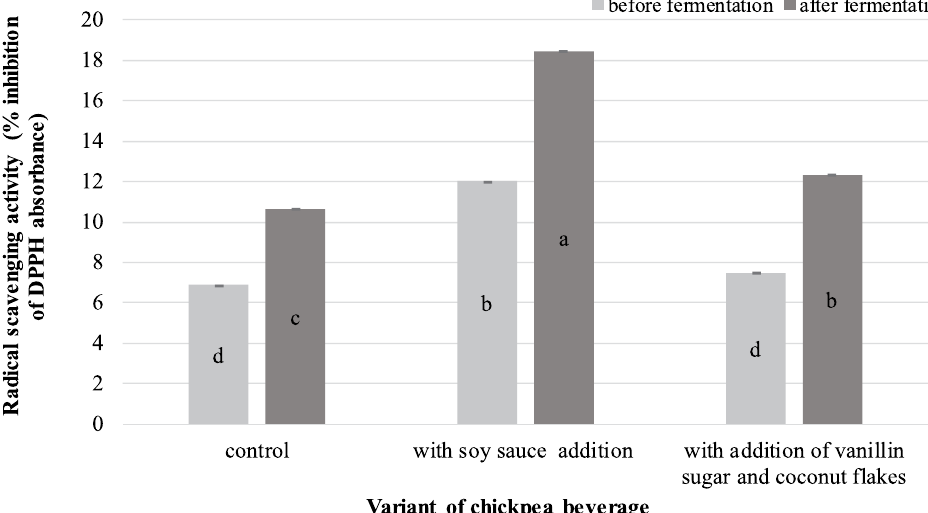
Fig. 1. Antioxidative activities exhibited by the analyzed chickpea beverages Explanatory notes: Mean values ± mean standard deviation (x ±s/SD; n = 3) with different letters indicate statistically significant difference